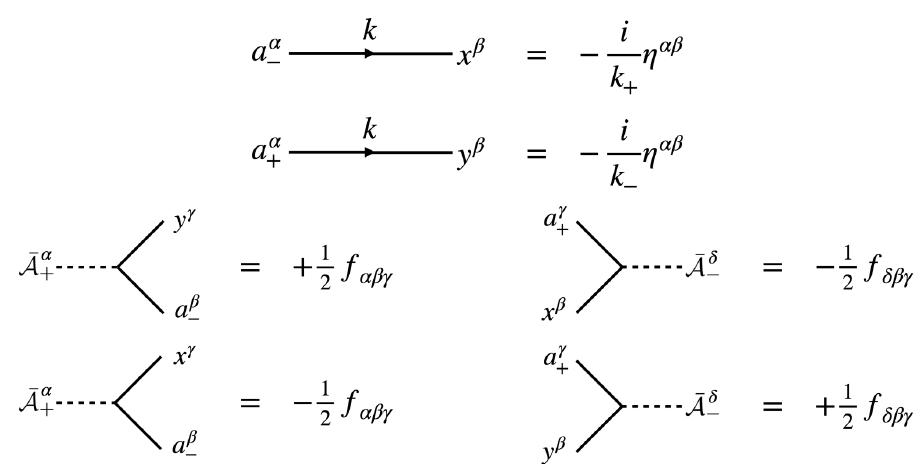
Figure 1 . The Feynman rules following from the path integral (2.18). Fluctuation fields and background fields are denoted by solid and dashed lines respectively. k ± denote the light-cone components of the 2d momenta. The indices α, β, γ label the Lie algebra generators T α , the structure constants are defined by [ T β , T γ ] = if α βγ T α and indices are raised and lowered by η αβ = Tr[ T α T β ] and its inverse η αβ (see conventions in appendix